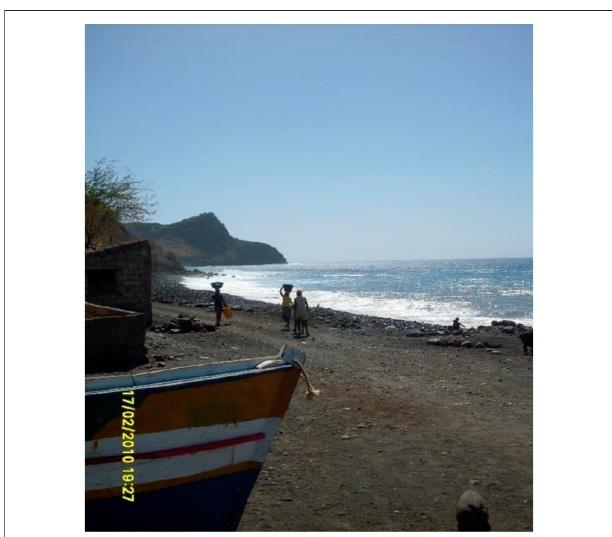
FIGURE 1 | Pathway from Ribeira da Barca to the Charco. Source: Images taken by the researchers, February 2010.